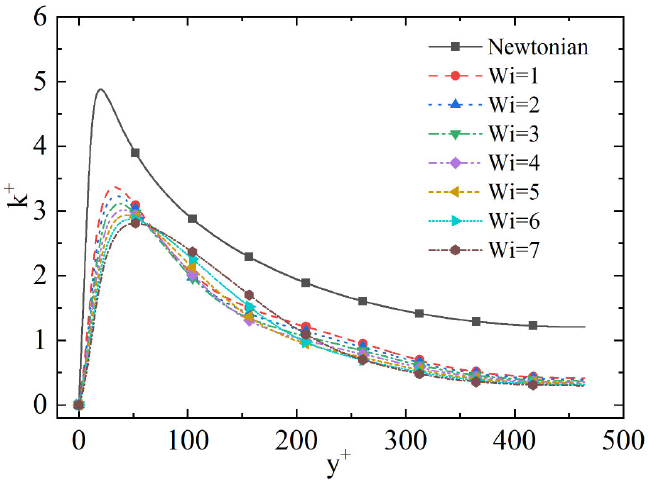
Figure 16. Dimensionless turbulent kinetic energy ( k + ) of different Weissenberg numbers ( Wi